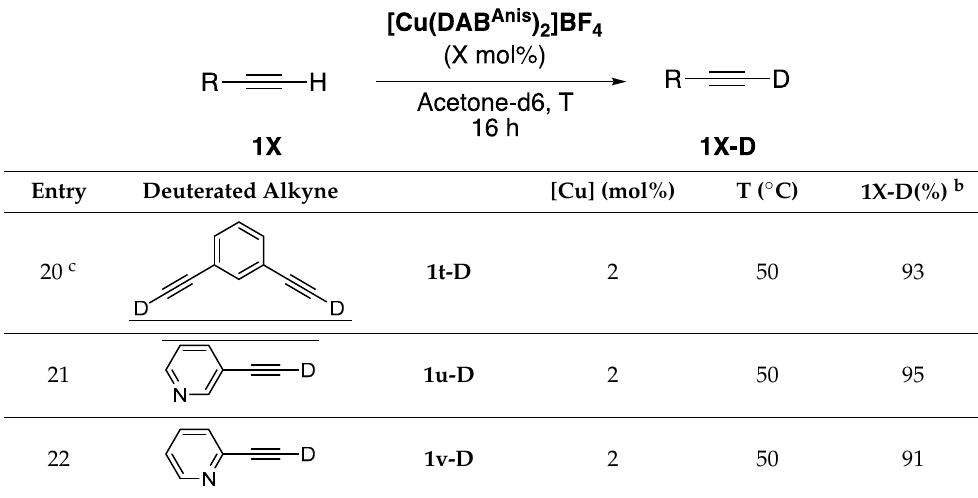
Table 3. Cont . Table 3. Scope of the reaction a .